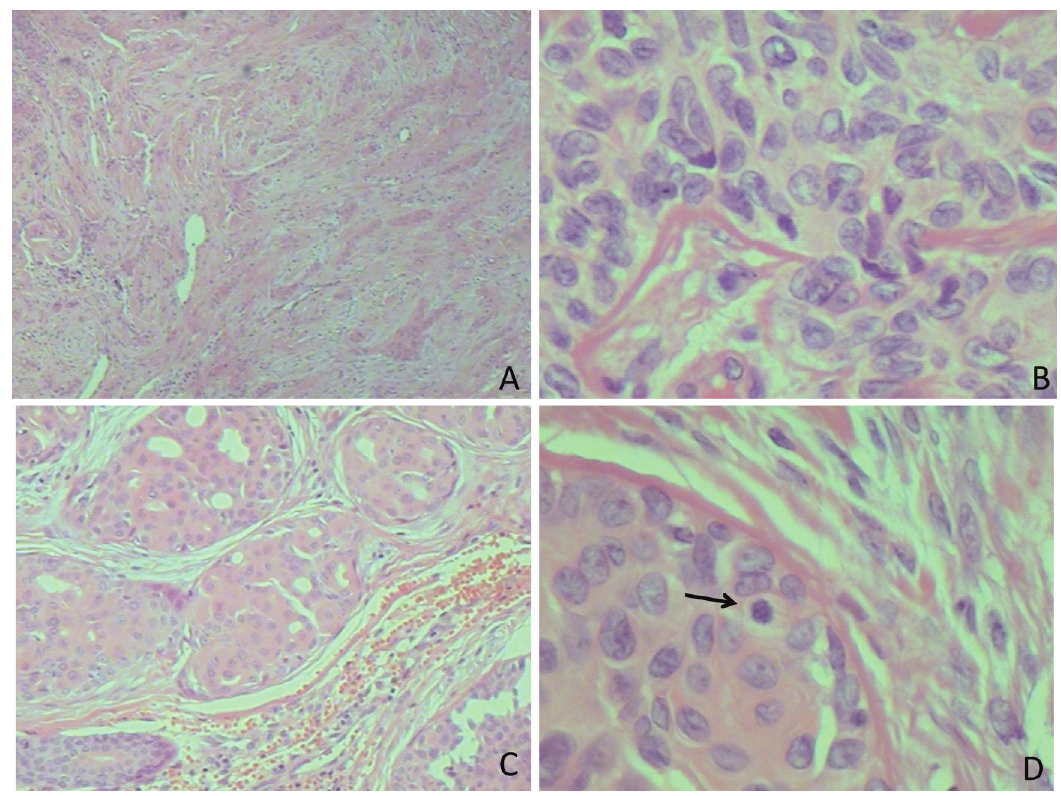
Figure 1 - Eccrine Porocarcinoma – Histology. A. diffuse infiltrative pattern, B. atypical elongated cells and central groove, C. duct formation, D. mitotic figure (arrow) Table 1 - Pathological report from the initial biopsy for eight cases with an eventual definitive eccrine porocarcinoma diagnosis. Patient Primary Lesion Size